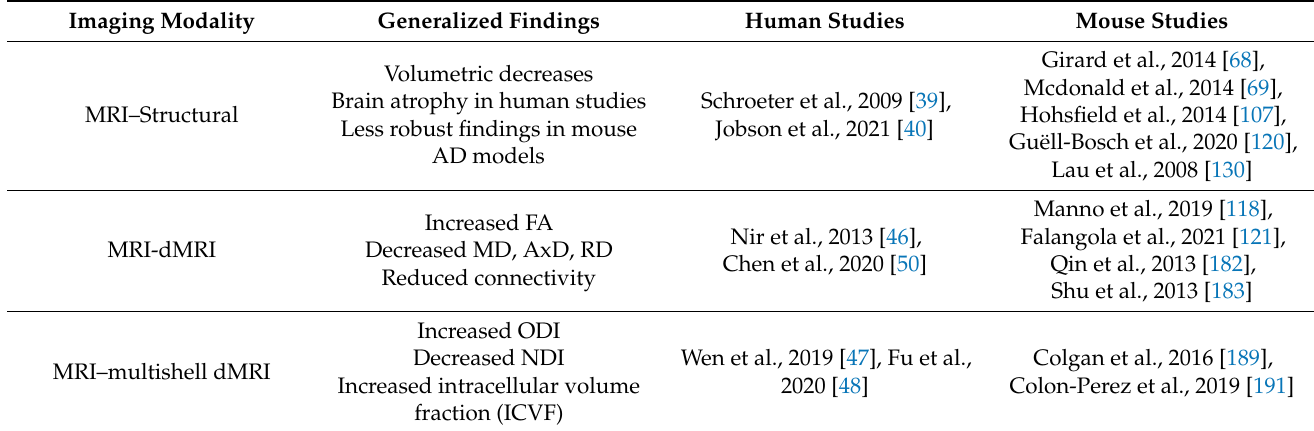
Table 4. Concordance between human and preclinical neuroimaging